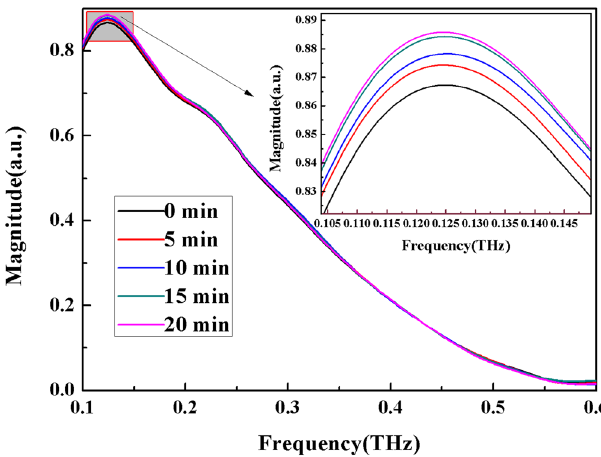
Figure 11. Frequency domain spectrum of H 2 O solution with different time electric field applied